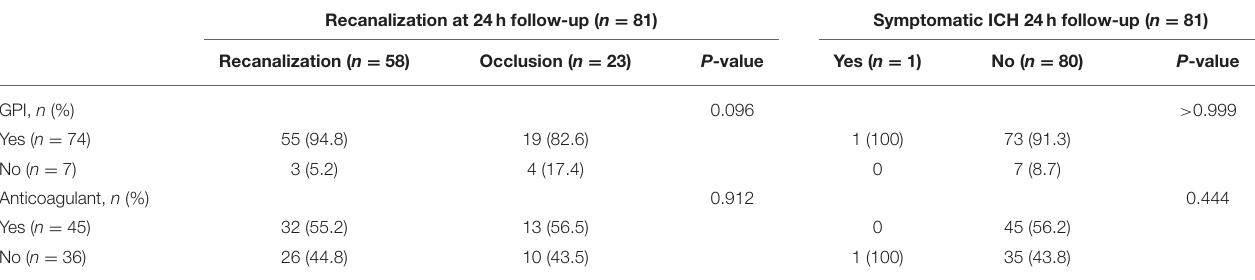
TABLE 3 | Relationships of glycoprotein IIb/IIIa inhibitor or anticoagulant use to patency and symptomatic ICH in rescue stenting group. Recanalization at 24h follow-up ( n = 81) Symptomatic ICH 24h follow-up ( n = 81) Recanalization ( n = 58)